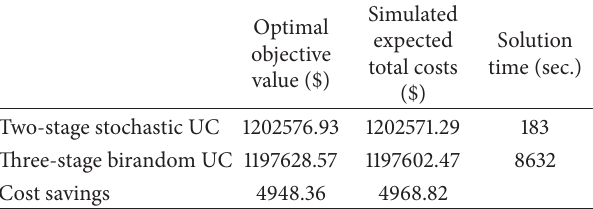
Table 7: Simulation results of the test case.